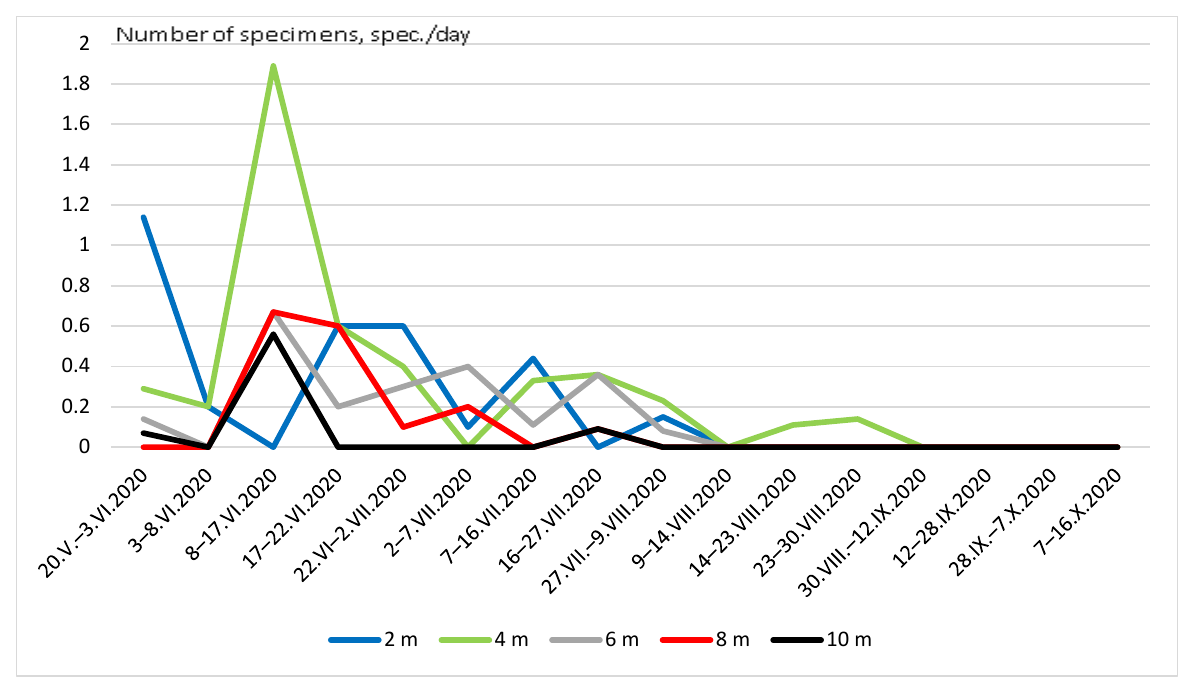
Figure 6. Seasonal dynamics of Protaetia marmorata abundance at different heights. The seasonal dynamics of P. marmorata abundance were more regular (Figures 6 and 7). The maximum number was recorded in mid-June, and then it decreased. In August, iso- lated individuals were observed in traps; since September, this species has not been ob- served.